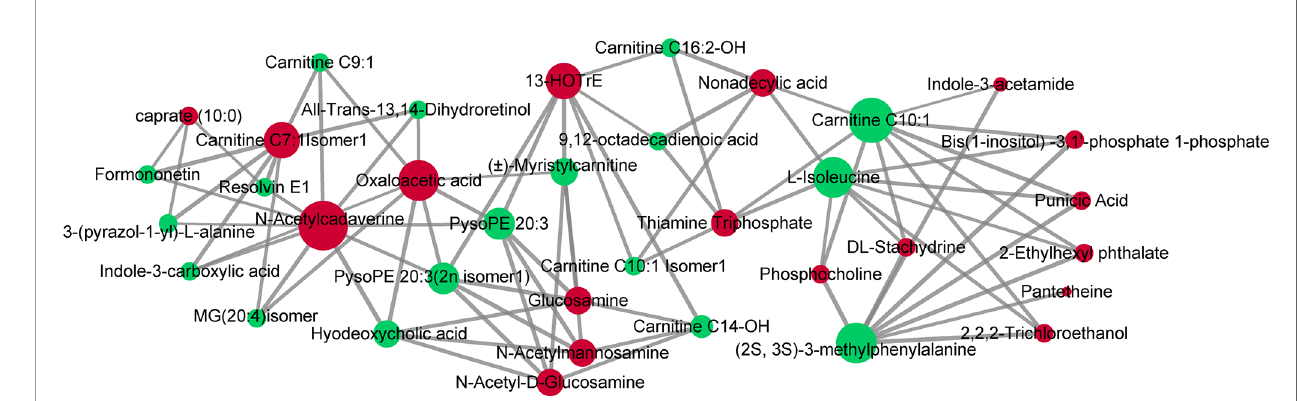
FIGURE 7 | Correlations of serum and tissue metabolites. Pearson ’ s correlation between 18 serum biomarkers and 18 tissue differential metabolites. The nodes represent metabolites (serum metabolites are green and tissue metabolites are red). The line between two nodes indicates correlation scores (only correlation scores of >0.6 are kept) and thicker lines indicate stronger